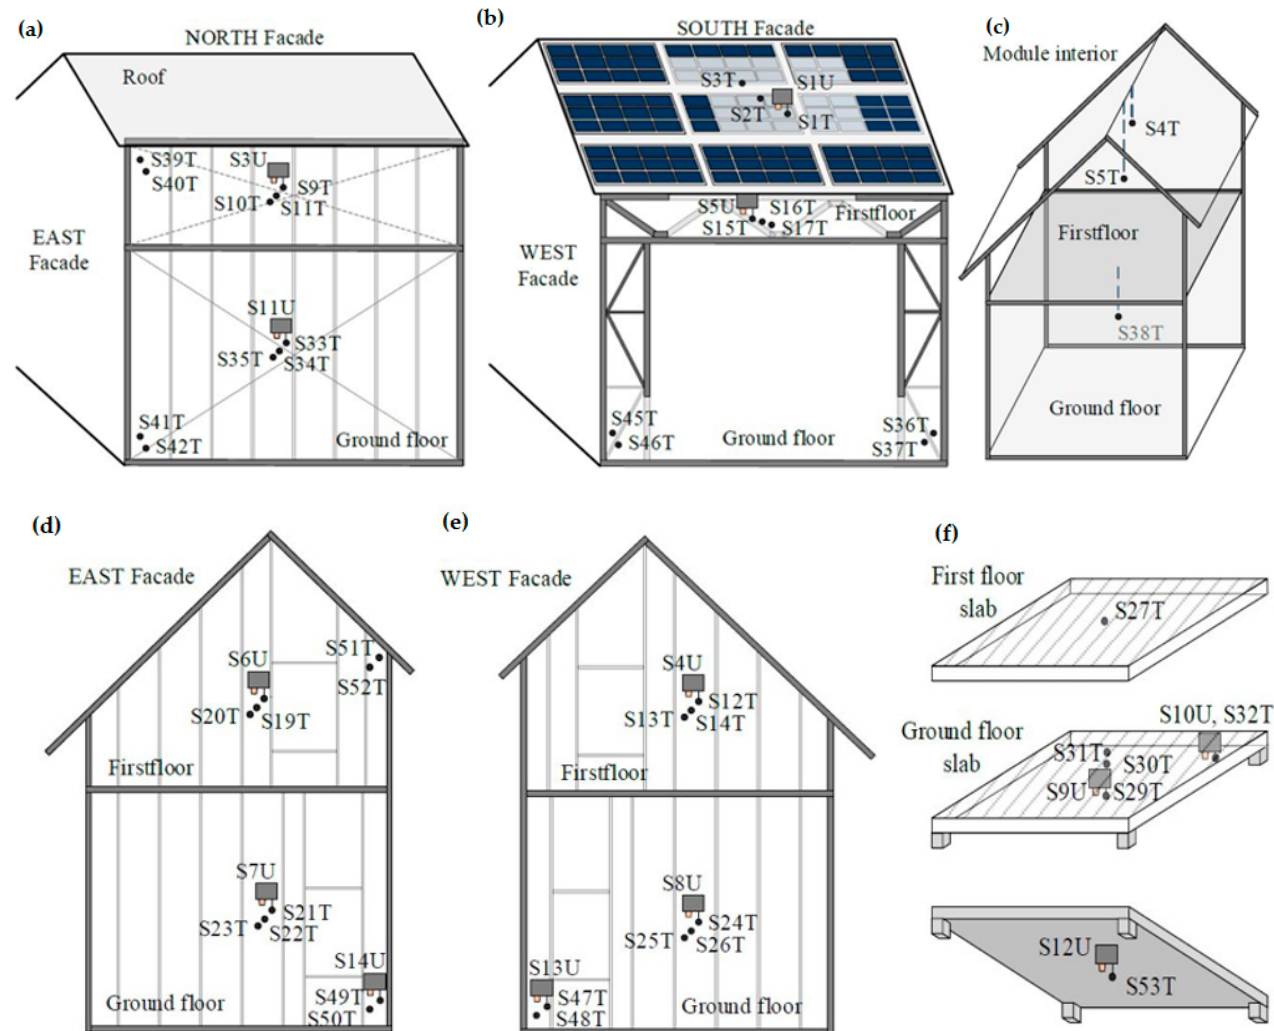
Figure 11. Sensors’ distribution on LSF experimental module: ( a ) north façade ( b ) southern façade and roof ( c ) interior ( d ) east façade ( e ) west façade ( f ) in slabs (adapted from [9]).